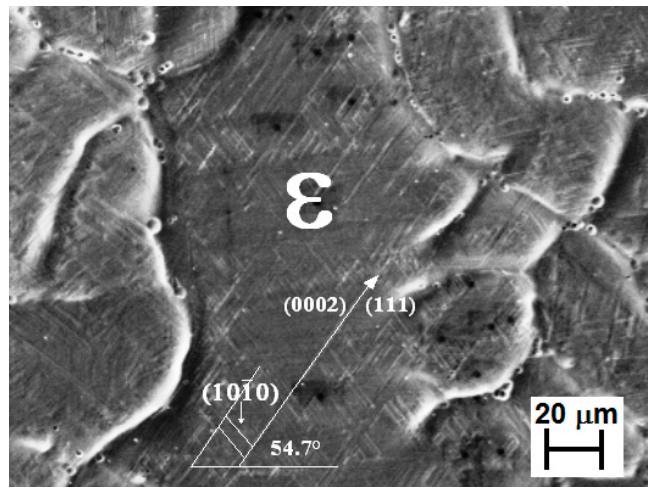
Figure 7. As-cast Co-20 wt. % Cr microstructure: scanning electron microscope (SEM) micrograph of the FCC γ -Co dendrites and athermal ε -martensite formed inside the dendrites. Figure 8a is a TEM micrograph with its corresponding diffraction pattern (Figure 8b) showing a fine distribution of elongated athermal ε -plates within the columnar dendritic structure.